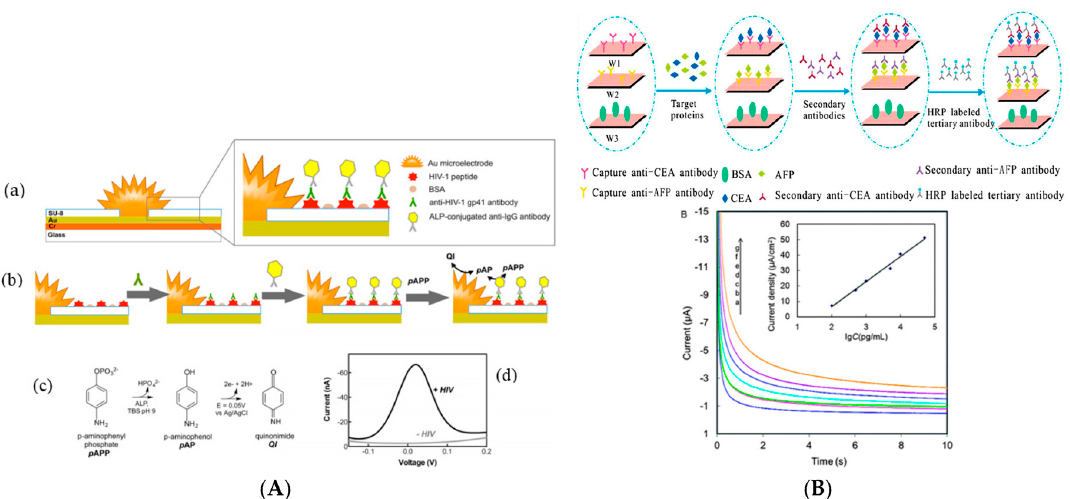
Figure 1. ( A ) ( a ) Au microelectrodes obtained by electroreduction of HAuCl 4 in 5 µ m apertures; ( b ) Immunorecognition. HIV-1 antigens are covalently immobilized on a SU-8 layer, then target antibodies are bound, followed by secondary AlkP-labelled anti-IgG binding. p-Aminophenyl phosphate (pAPP) is added as substrate; ( c ) Transduction: ( c ) AlkP converts pAPP to p-aminophenol which is electrooxidized at the electrode and produces a current proportional to the amount of target antibody bound to the sensor; ( d ) Resulting DPV. Reprinted with permission from [12]. Copyright 2013 American Chemical Society; ( B ) Above . Detection principle of the screen-printed bi-analyte array, including a BSA (reference) electrode. Below . Change in current for different concentrations of AFP, for blank (lowest current) to 50 ng mL − 1 (highest current); calibration curve in inset. Adapted from [15] with permission from The Royal Society of